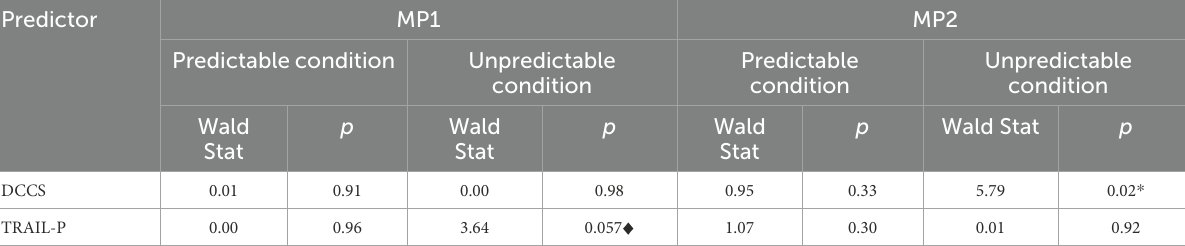
TABLE 3 Effect of flexibility scores on goal change scores (logistic regression).